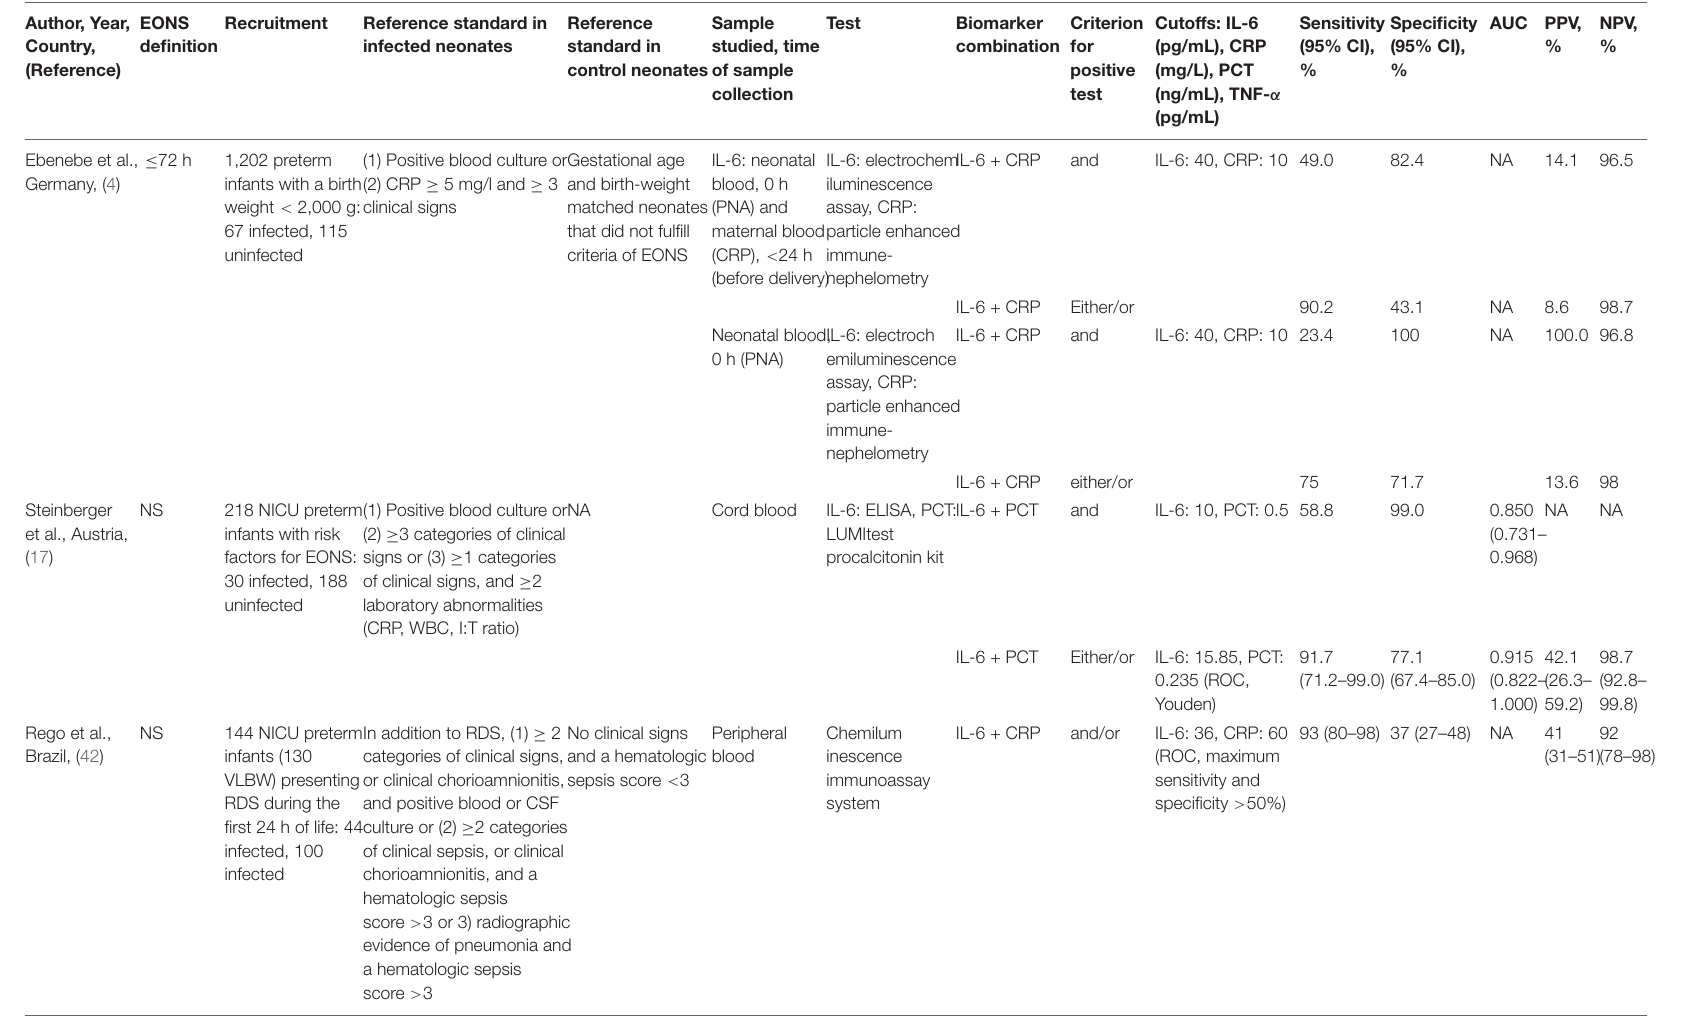
TABLE 3 | Characteristics of IL-6 accuracy studies for diagnosing EONS using biomarker combinations. Author, Year,